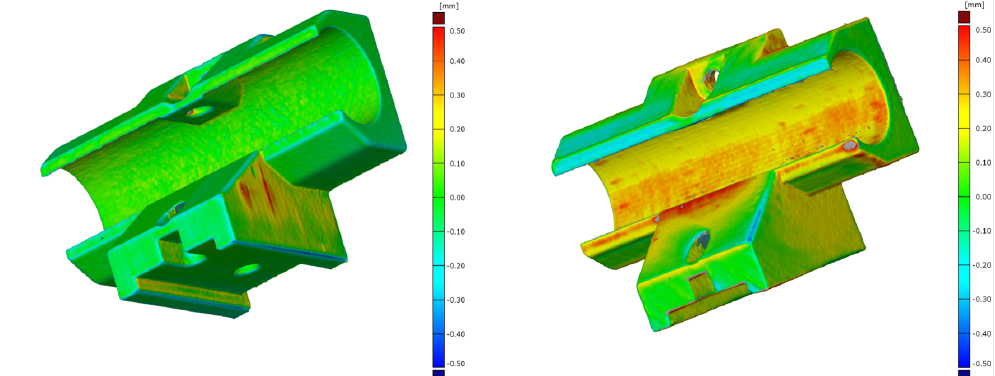
Figure 16. Shape deviation (CAD vs. print) on Prusa ( left ) and RotBot ( right ).